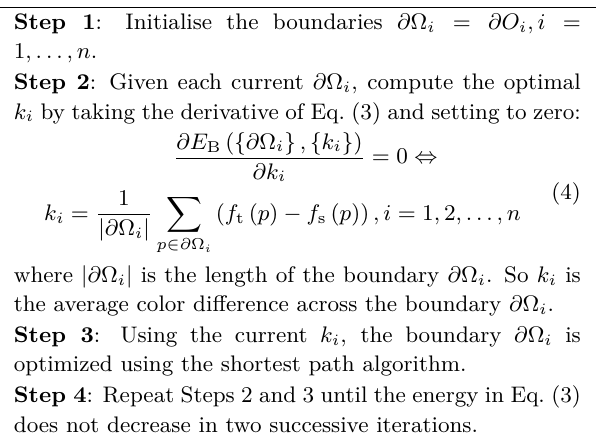
Algorithm 1 Computing optimal